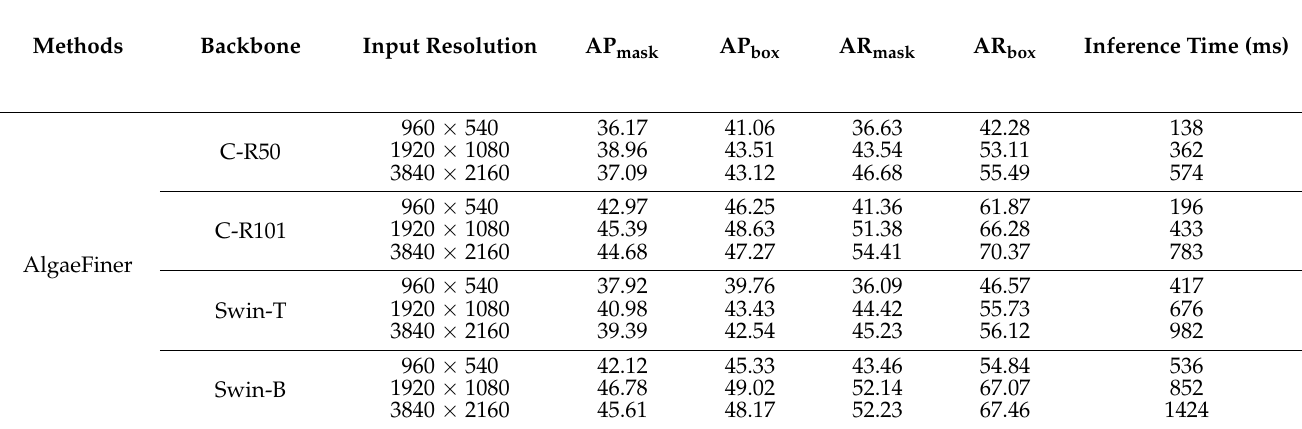
Table 7. The variation of AP mask ,AP box , AR mask , AR box and inference time under different resolutions.